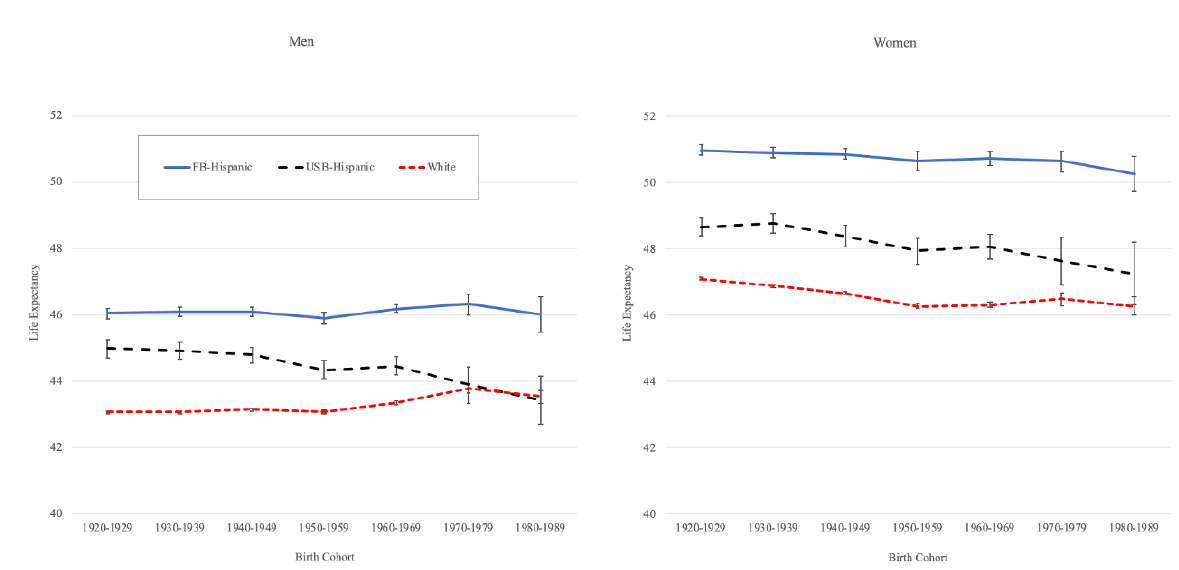
Figure 3: Simulated change in life expectancy at age 35 associated with cohort compositional changes in smoking and weight status at age 25. Source: 1989 to 2014 National Health Interview Survey and 1999 to 2014 National Health and Nutrition Examination Survey. FB, foreign-born; USB,